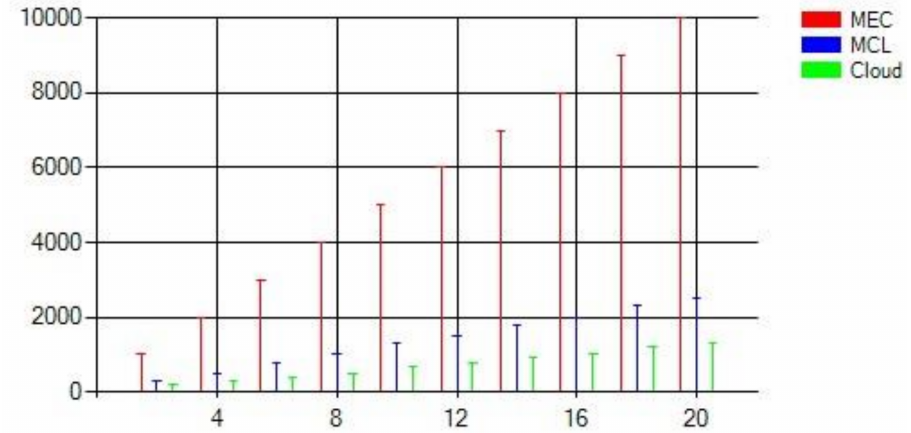
Figure 12. The computation time of MEC, the MCL, and Cloud.